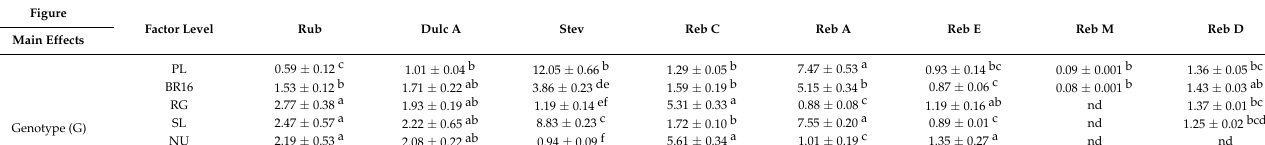
Table 6. Results of three-way ANOVA for steviol glycoside